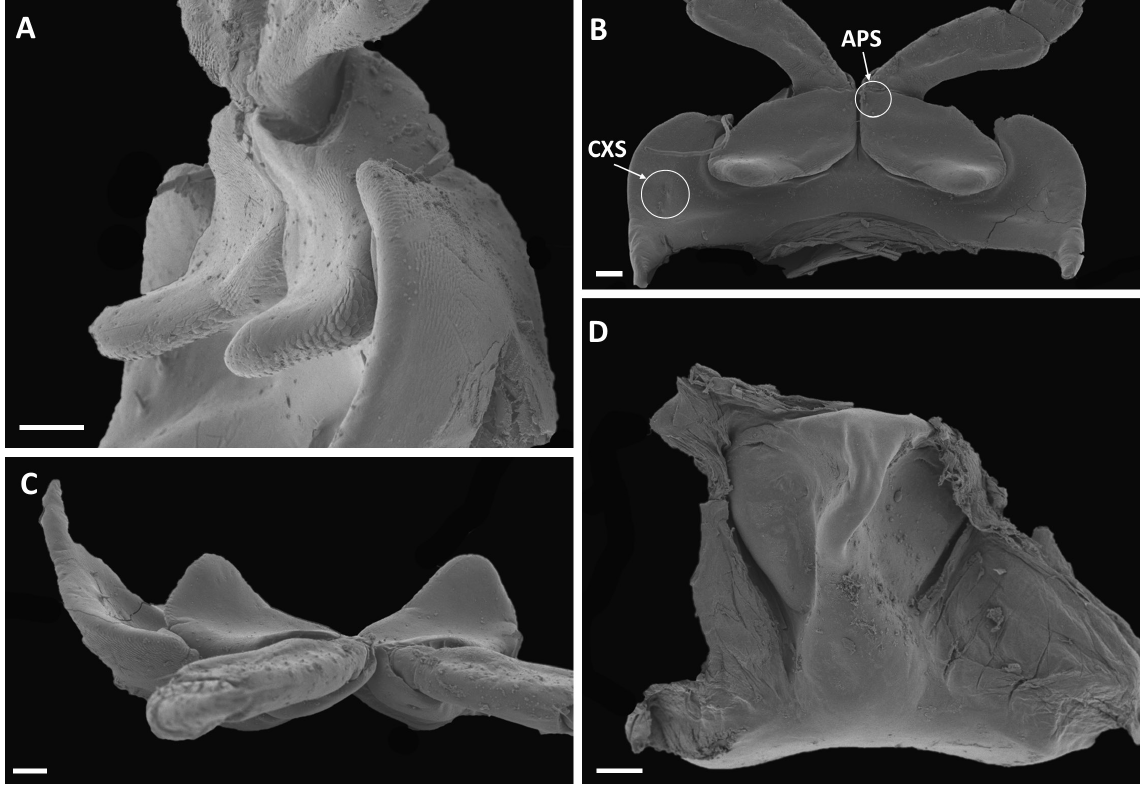
Fig. 40. Lamelloramus frederiksenae sp. nov., holotype, ♂ (NHMD 621744). A–C . First pair of legs. A. Sublateral view. B. Anterior view. C. Ventral view. D . Sternum 9. Abbreviations: APS = mesapical prefemoral setae; CXS = coxosternal setae. Scale bars = 0.1